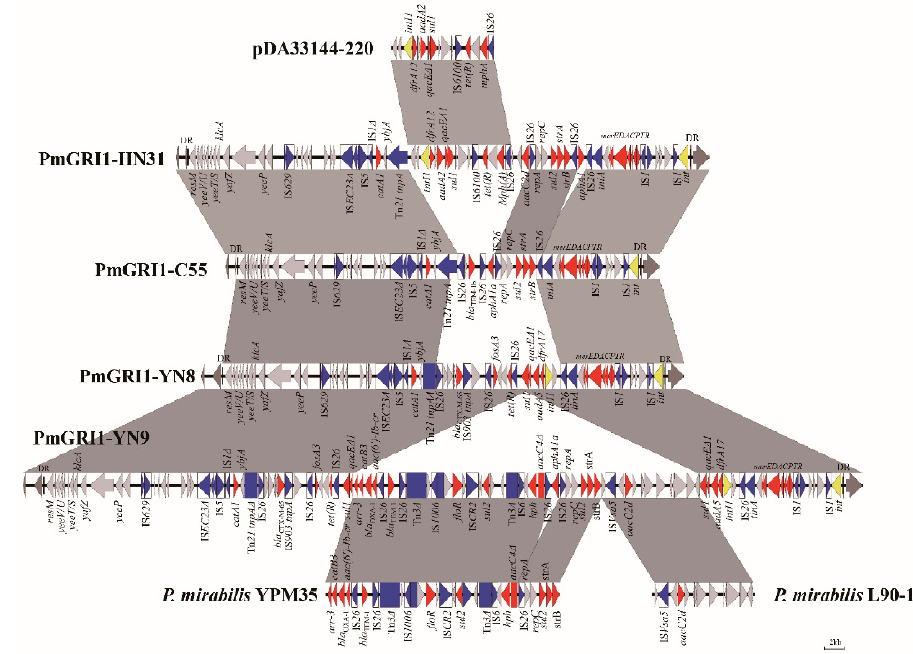
Figure 1. Genetic structure of three novel variants of PmGRI1. Structures were drawn to scale from NCBI accession numbers MW699442 (PmGRI1-HN31), MW699444 (PmGRI1-YN8), MW699445(PmGRI1-YN9), MK861851 (PmGRI1-C55), CP029591 (pDA33144-220), CP053898 ( P. mirabilis YPM35), and CP045257 ( P. mirabilis L90-1). Genes and open reading frames are indicated by arrows, and arrowheads indicate their orientations of transcription. Shared regions are indicated by shading with >99% identity. Antimicrobial resistance genes are shown in red, and transposase genes are shown in blue. The yellow arrow represents the integrase gene. The gray arrows represent other functional genes that have nothing to do with this research. The IS elements are indicated by boxes around the blue arrows. DR represents the 20 bp direct repeats at the ends of PmGRI1.